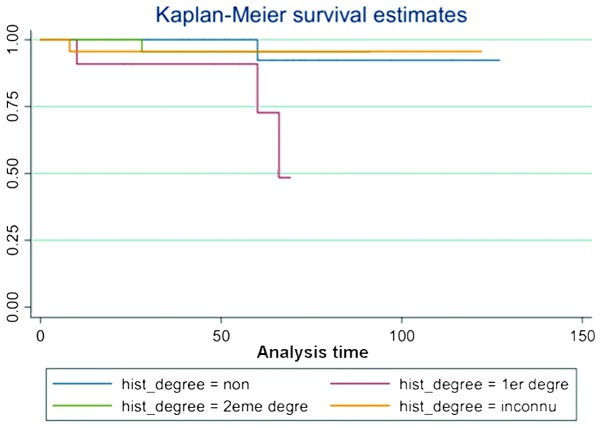
Disease-free survival by family history (Kaplan-Meier). The Kaplan-Meier estimates revealed that the first degree of family history, which describes the family member with breast cancer (daughter, mother or sibling), is the most important for the occurrence of new contralateral breast cancer. Whilst the second degree of family history (aunt or niece), without family history or other status, lessens the revolution. Hist_degree, degree of family history; non, no family history; 1ere degree, first degree family history; 2eme degree, second degree family history; inconnu, unknown.